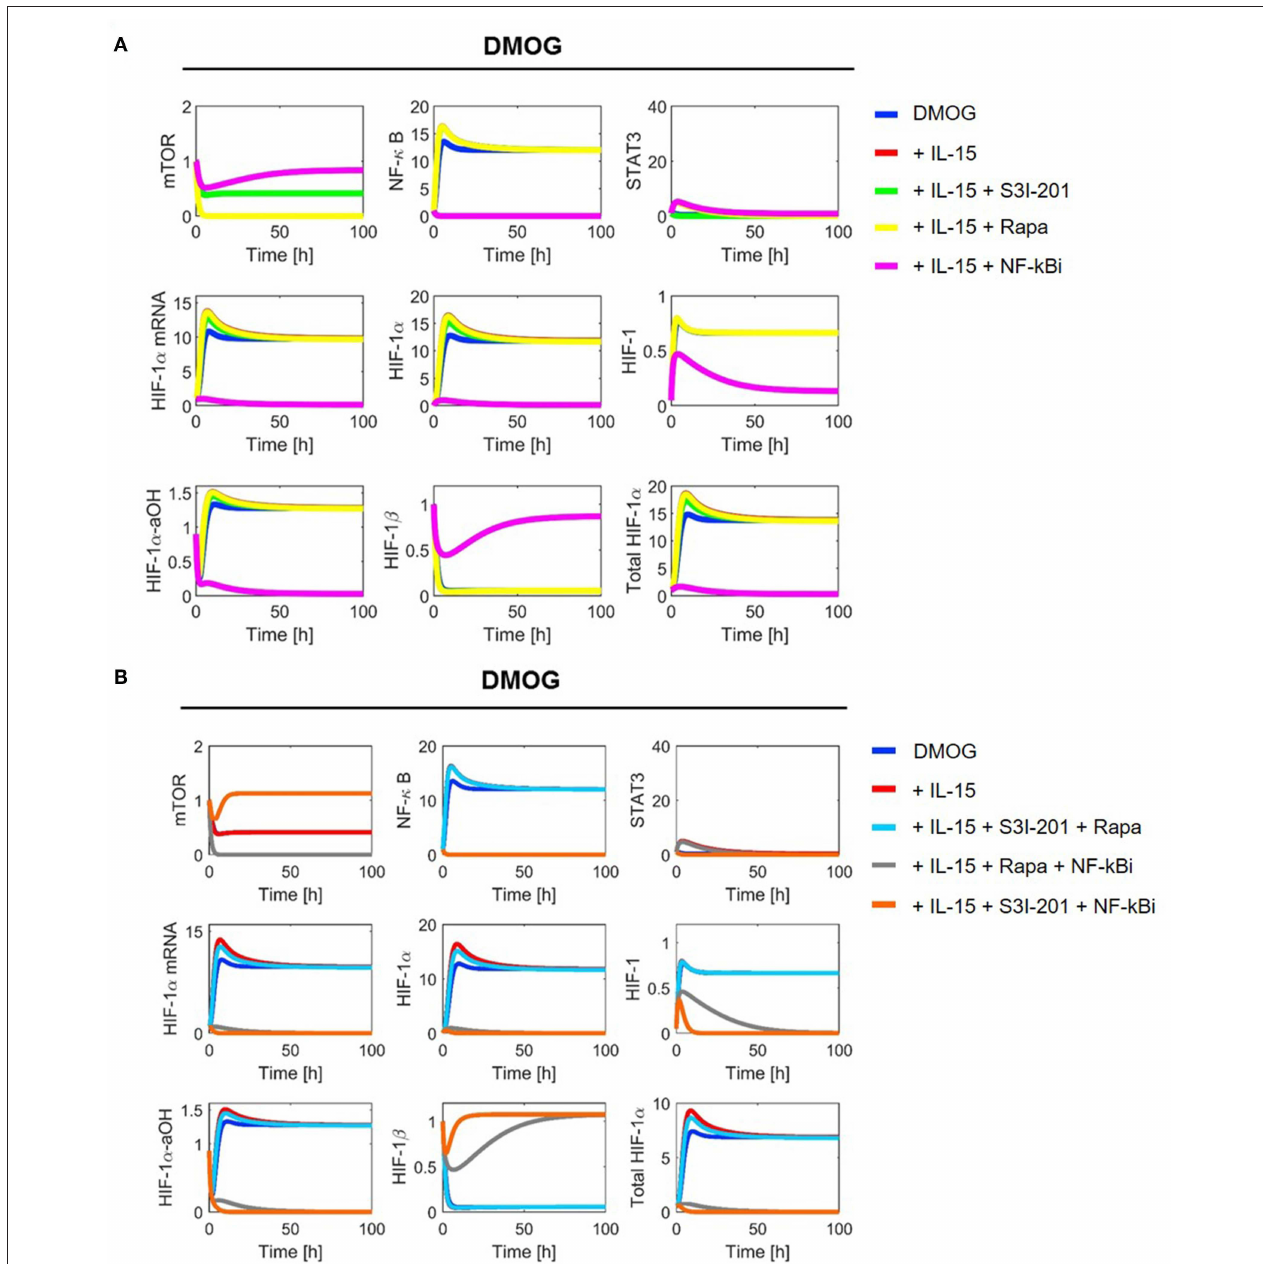
FIGURE 5 | Model simulation in chemical hypoxia (20 µ M DMOG): (A) with one inhibitor and (B) with two inhibitors. Colors indicate the following experimental settings: (blue) untreated cells; (red) cells primed with IL-15; (green) cells primed with IL-15 and treated with STAT3 inhibitor S3I-201; (yellow) cells primed with IL-15 and treated with mTOR inhibitor rapamycin (Rapa); (magenta) cells primed with IL-15 and treated with NF- κ B inhibitor (NF- κ Bi); (cyan) cells primed with IL-15 and treated with STAT3 inhibitor and rapamycin; (gray) cells primed with IL-15 and treated with NF- κ B inhibitor and rapamycin; (orange) cells primed with IL-15 and treated with NF- κ B and STAT3